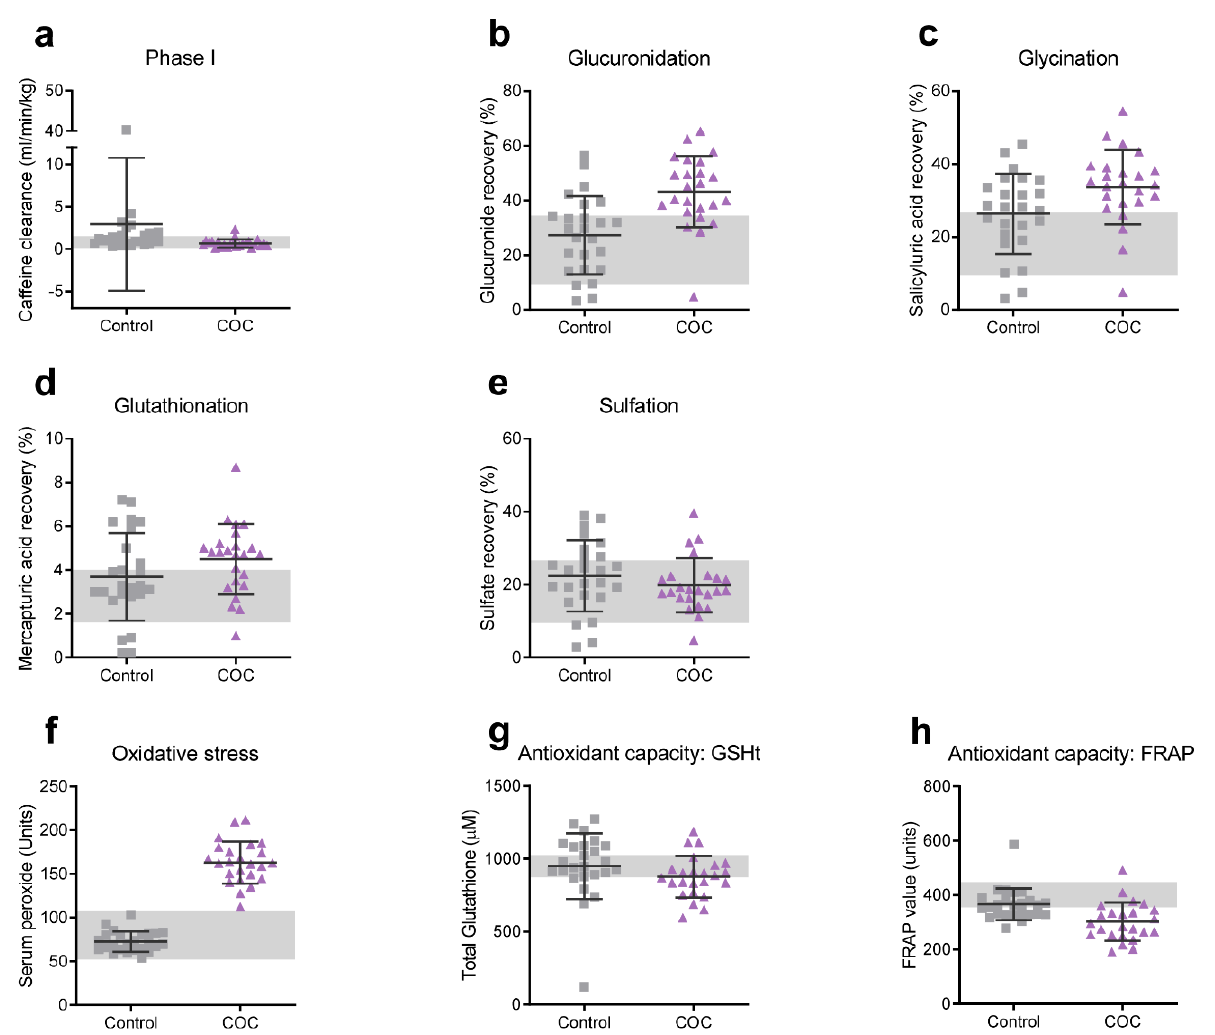
Figure 3. Untransformed data of phase I and II biotransformation efficiency, serum peroxides, and antioxidant capacity. ( a ) Phase I (CYP1A2) activity was measured as the caffeine clearance rate in saliva. Phase II (conjugation) efficiency was assessed by measuring the recovery of ( b ) APAP glucuronide, ( c ) salicyluric acid, ( d ) APAP mercapturic acid, and ( e ) APAP sulfate in urine. ( f ) Serum peroxides were measured as an indicator of oxidative stress and ( g ) total red blood cell glutathione and ( h ) ferric reducing ability of plasma as indicators of antioxidant capacity. Squares and triangles represent individual controls and COC users, respectively. Horizontal lines and error bars indicate means ± SD. Shaded background indicates reference ranges obtained by our own laboratory from a South African Caucasian group of 46 healthy individuals between the age of 18 and 35 years (22 men and 24 women).